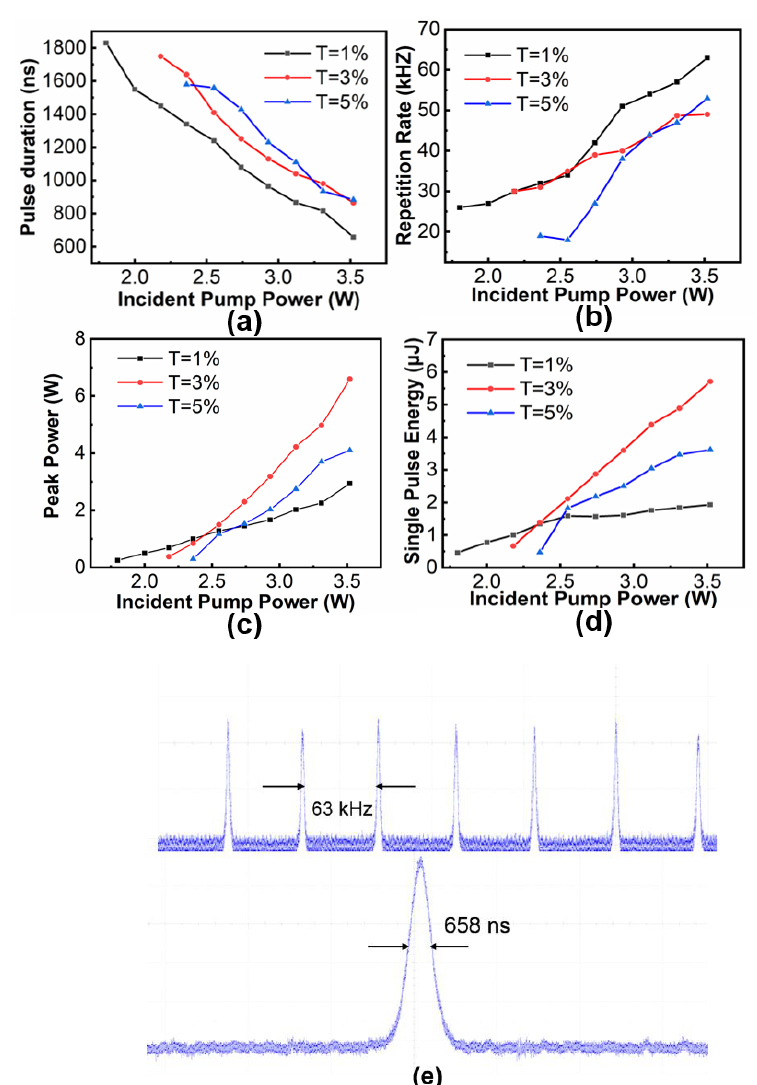
Figure 4. ( a ) Pulse duration; ( b ) pulse repetition rate; ( c ) single-pulse energy and ( d ) peak power versus the incident pump powers from the PQS laser. ( e ) Typical pulse train and temporal pulse profile.